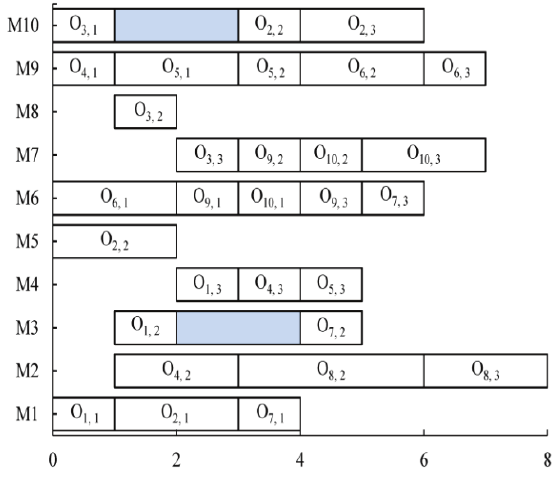
Fig. 6 Optimal Solution for 10X10 instance ( f